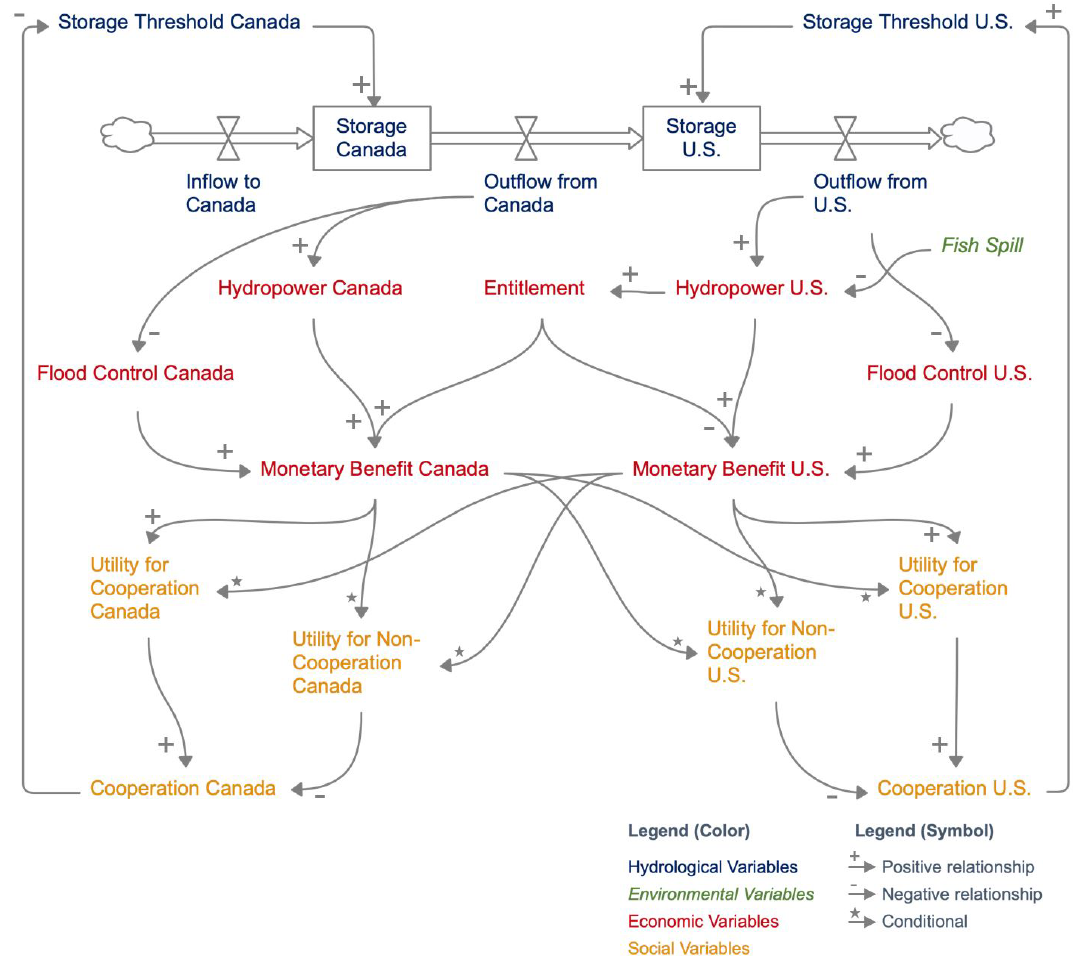
Figure 2. The causal loop diagram presents the hydrological and cooperation feedbacks between the Canada and the United States. Different colors shows the hydrological, environmental, economic, and social